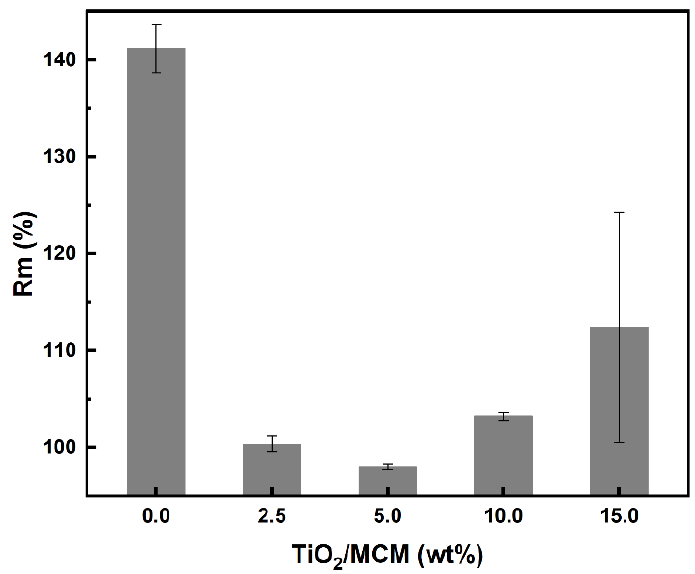
Figure 7. Toluene swelling ratio, (R m ) %, of PDMS and TiO 2 /MCM/PDMS composites. In general, a decrease in the swelling ratio is associated with an increase in the crosslink density. However, as shown previously through the FTIR analysis, all samples, regardless of the TiO 2 /MCM concentration, reached a similar degree of crosslinking, implying that the adsorbent has a weak interaction with the PDMS polymer matrix. As suggested by Gupta et al. [30], the adsorbent reduces the free volume between the polymer molecules, and thus, partially inhibits the solvent from entering the matrix during